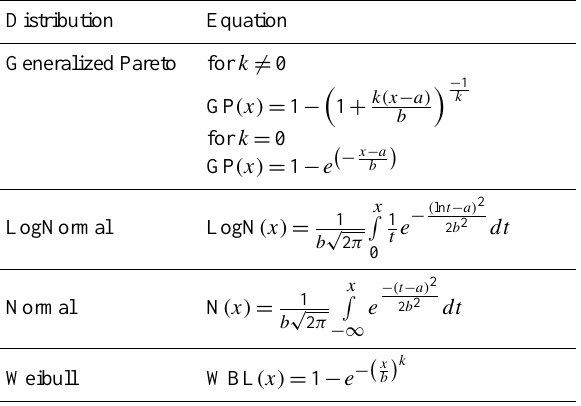
Table 1. Distribution functions considered in the present study to be fitted to the time series resulting from the parameterisation of the observed storm surge